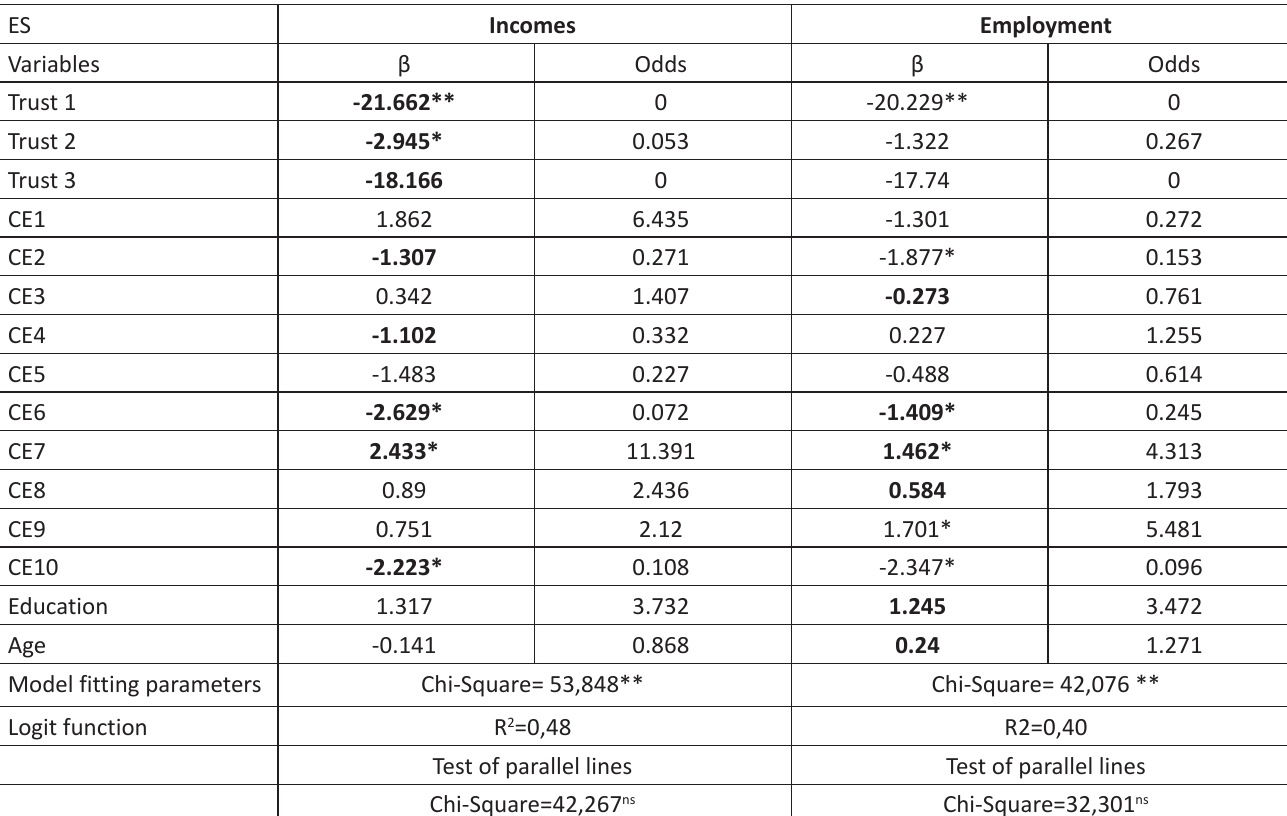
Table 5. Results of proportional odds model results linked to socio-economic ES provided by the pastoral ecosystem and social capital